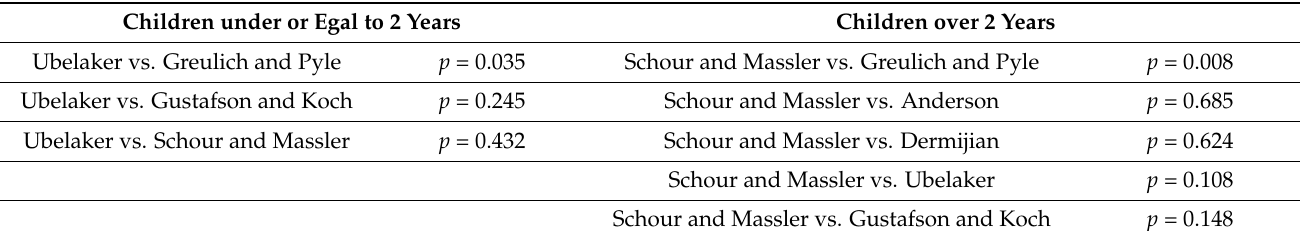
Table 4. Comparison of inaccuracy between methods of age